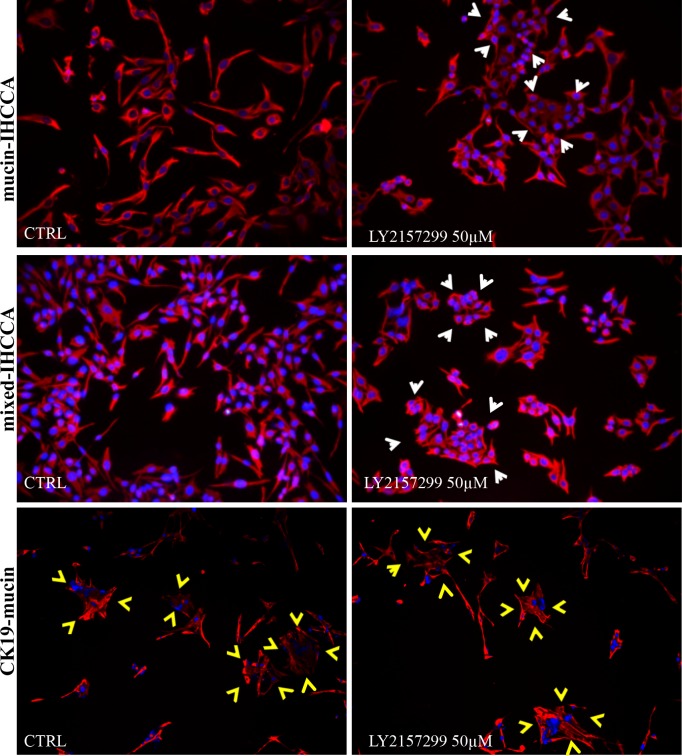
Immunofluorescence for vimentin in cell cultures treated with the TGF-ΒR1 inhibitor LY2157299.Expression of vimentin was unchanged by LY2157299. However, IF for vimentin (red) highlighted evident morphological changes in mucin- and mixed-IHCCA cell cultures treated for 72 hrs with the TGF-ΒR1 inhibitor LY2157299 (50 μM). LY2157299 induced the loss of typical mesenchymal features, instead favoring the epithelial phenotype with formation of cell clusters (white arrows). No morphologic change was induced by LY2157299 in CK19-mucin cell cultures. Cell clusters with undefined edges, a typical feature of the epithelial phenotype, were observed in mucin- and mixed- IHCCA cells treated with LY2157299 (white arrows) and in CK19-mucin (yellow arrows, similar in treated and untreated cells). Mean +/- SD of N = 3–5 independent experiments.